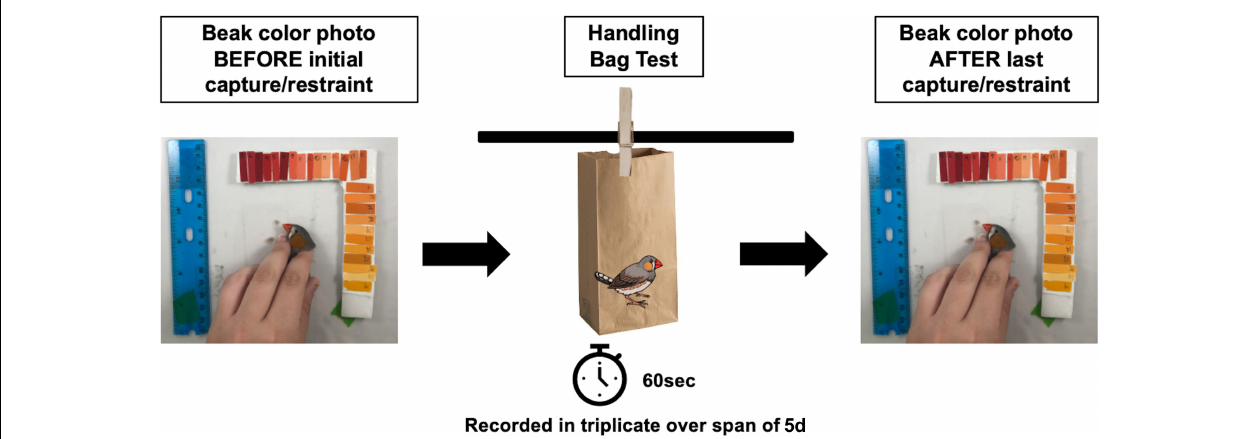
FIGURE 2 | Handling bag test experimental design. Zebra finches at an average age of 386 dph participated in a handling bag test. Prior to the first handling bag test, beak color photos of each bird were taken. Then, each bird was placed in a brown, opaque paper bag and restrained for 1 min, and the time spent moving (“activity,”) was recorded. The handling bag test was conducted in triplicate every other day (over span of 5 days) for each bird to ensure for a recovery period. At the conclusion of the third handling bag test, another beak photo was